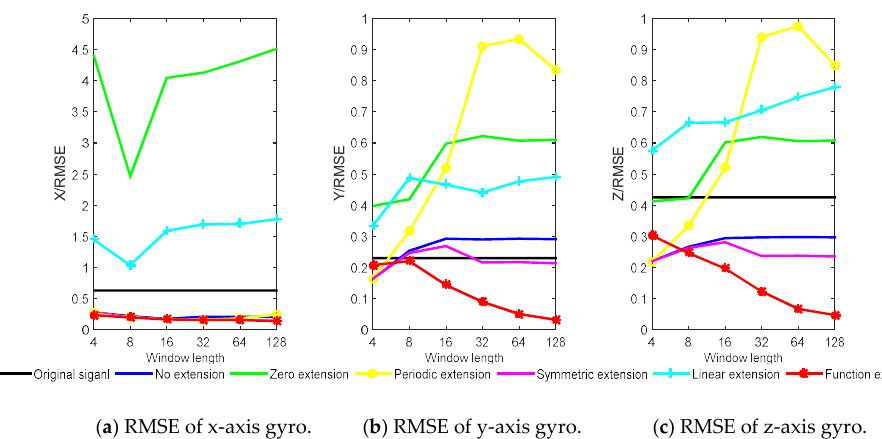
Figure 7. Simulation results of SNR for different extension methods.